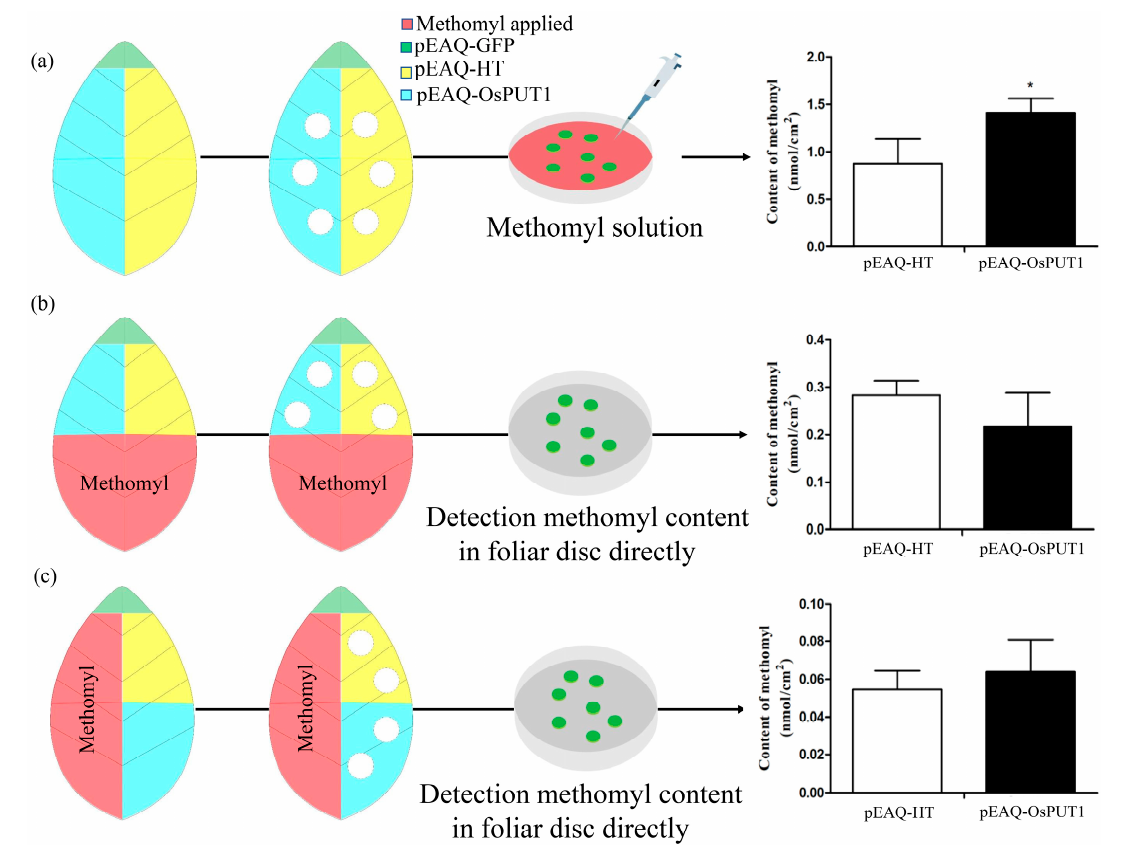
Figure 5. Uptake of methomyl by N. benthamiana foliar discs expressing OsPUT1 after methomyl application to leaves by the use of different methods. ( a ) Methomyl content in foliar discs expressing pEAQ-HT and OsPUT1. Foliar discs were immersed in a methomyl solution to measure uptake. ( b ) Content of methomyl in foliar discs expressing pEAQ-HT and OsPUT1 ; methomyl was applied to the top half of leaves and foliar discs from down half were subjected to methomyl detection directly. ( c ) Content of methomyl in foliar discs expressing pEAQ-HT and OsPUT1; methomyl was applied to the right side of leaves and foliar discs from left side were subjected to methomyl detection directly. The data are presented as the means ± standard deviations ( n = 5) (* p ≤ 0.05).